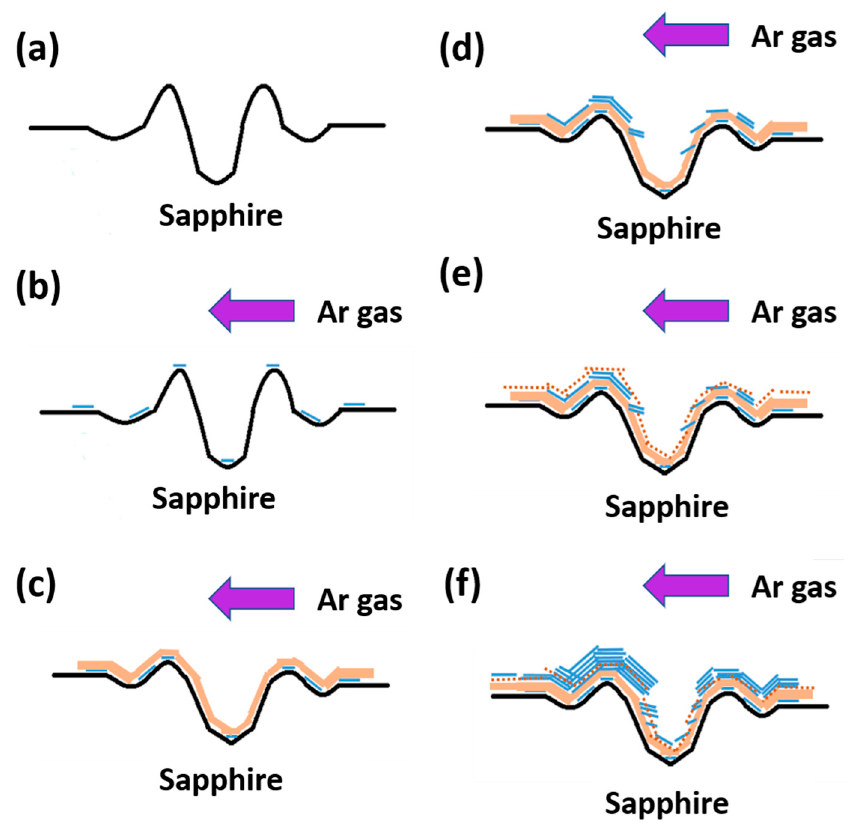
Figure 8. Schematic of the growth process of MoS 2 . The purple arrow in the figure is the direction of argon ventilation, the blue line segment represents a single layer of MoS 2 , the light yellow area represents the mixed zone dominated by MoO 3 , the dark yellow dot is amorphous Al 2 O 3 mixed in the reflection, and the blue line segment is superimposed to represent multilayer MoS 2 .